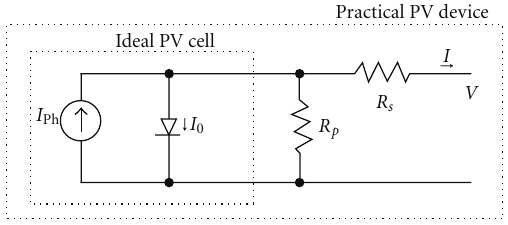
Figure 1: PV cell modeled as diode circuit.